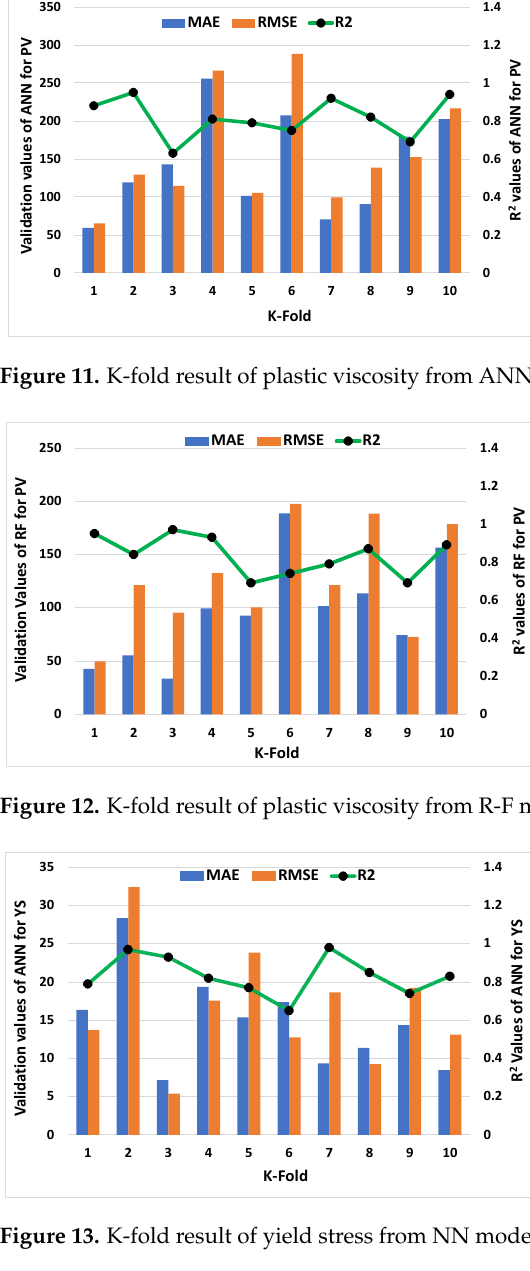
Table 3. Statistical outcomes of plastic viscosity for employed models.